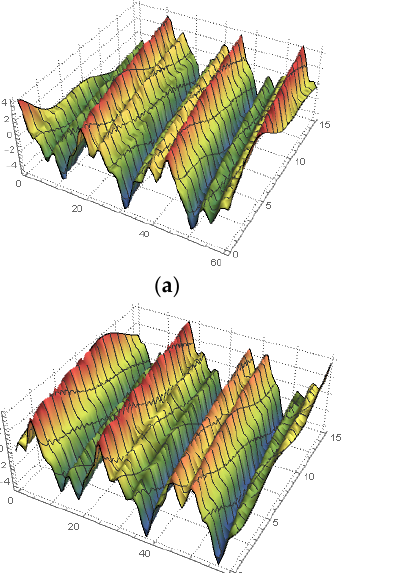
Figure 4. The 3D plots of the real and imaginary parts of